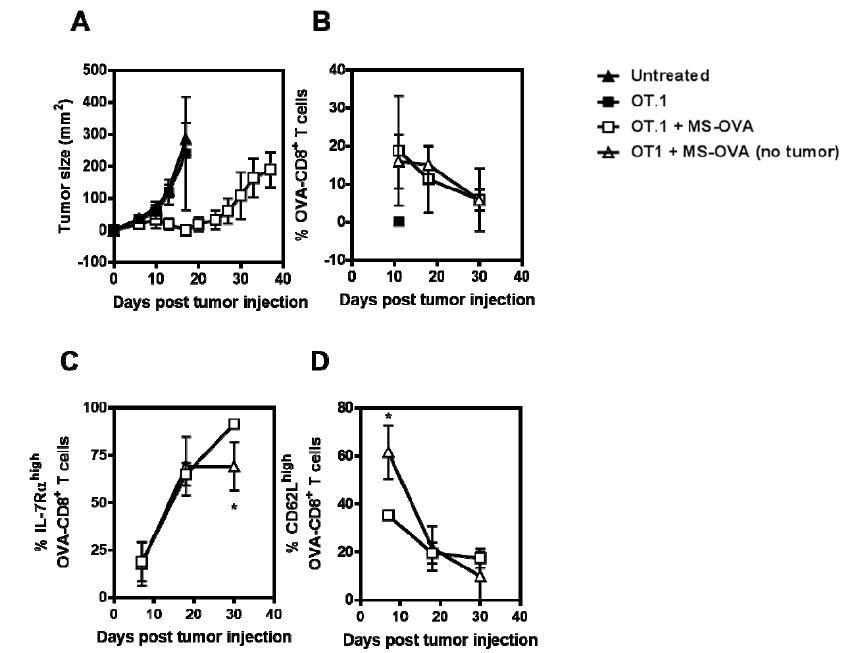
Figure 4. Frequency and phenotype of responding OVA 257-264 -specific CD8 + T cells. C57BL/6 mice were given 10 6 B16-OVA tumor cells s.c. in the dorsal flank. Two days later, 10 5 OT.1 splenocytes were given intravenously. On days 3 and 8 after tumor injection, 20 μ g MS-OVA was injected s.c. at the base of the tail away from the tumor site. ( A ) Tumor growth was measured over time. At varying time points blood was collected for FACS analysis of ( B ) OVA-CD8 + T cells, and their expression